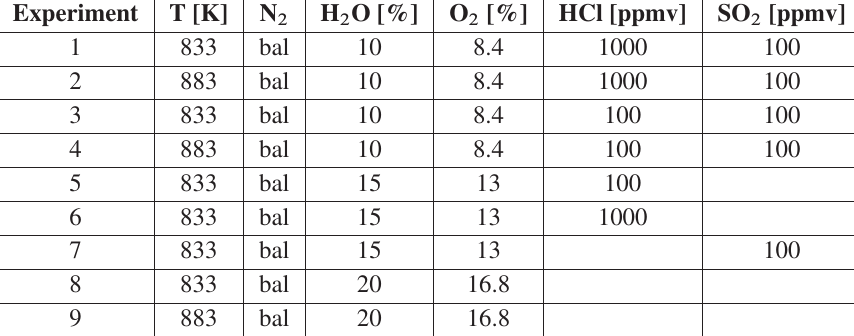
Table 1. Chemical compositions (in mass %) of the steels.